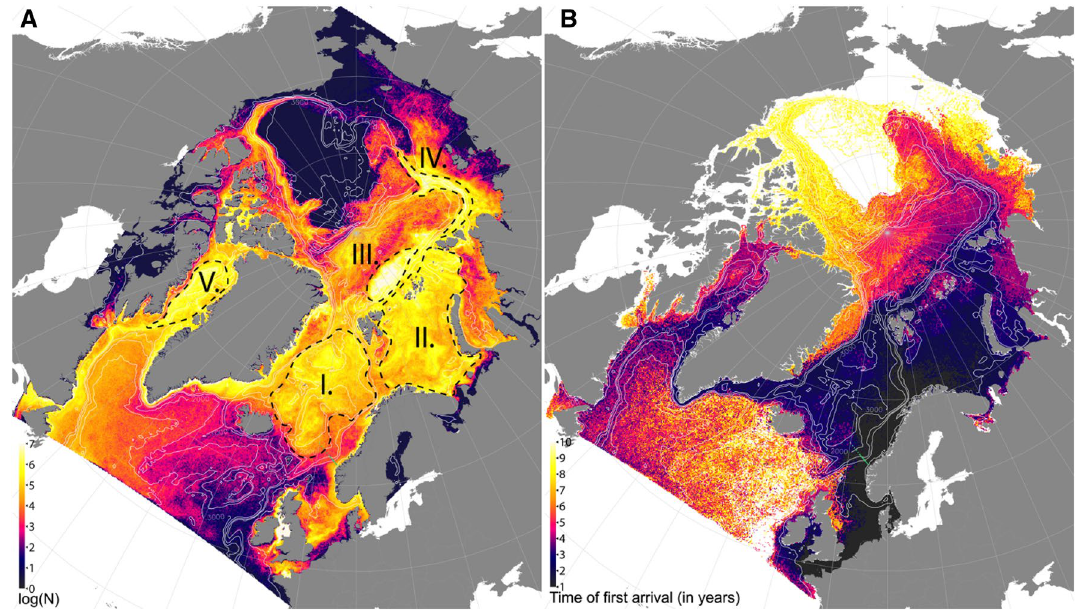
Figure 3. Ocean accumulation zones and estimated time of arrival of European BMP to the high Arctic. ( A ) Integrated abundance of BMP per 4 km × 4 km grid cell over daily concentration fields of the 20th year of simulated advection, plotted on a logarithmic scale. Denoted with roman numerals are the accumulation zones: (I) Nordic Seas, (II) Barents Sea, (III) Nansen Basin, (IV) Laptev Sea shelf edge, and (V) Baffin Bay. Due to the limited ability of the 4 km ocean model grid to resolve near-shore, small scale currents, the apparent accumulation areas near land and in enclosed areas (e.g. the Irish Sea, Franz Joseph Land, eastern coast of Greenland, and Canadian Archipelago) may be artifacts of the model and thus has to be interpreted with caution. Small green dots represent the 17 sampling locations along the Svinøy transect, see also Fig.